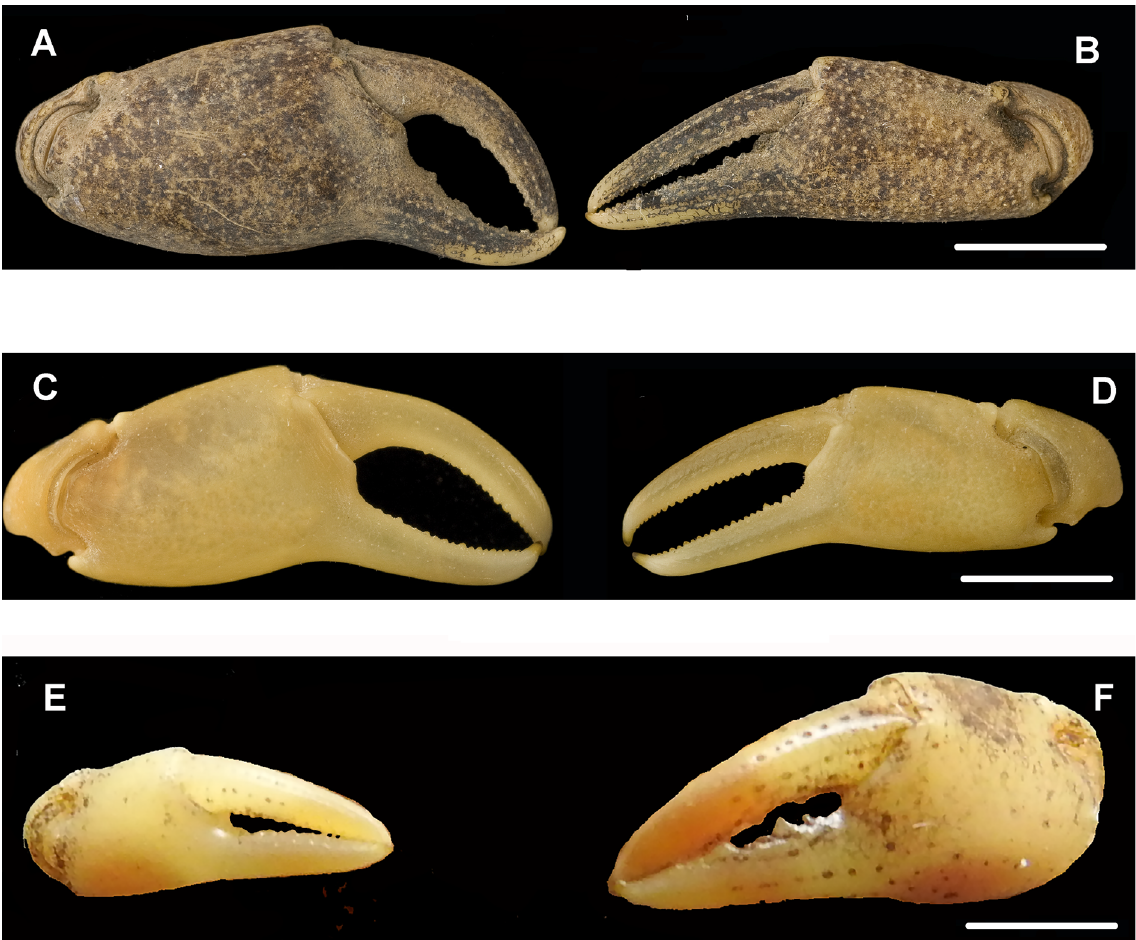
Fig. 5. Frontal view of left and right chelipeds. A–B . Potamonautes entebbe sp. nov., holotype, adult ♂, CW 35 mm, from Entebbe in southern Uganda (NHMUK 1955.11.8.26). – C–D . Potamonautes busungwe sp. nov., holotype, adult ♂, CW 21.5 mm, from Entebbe in southern Uganda (NHMUK 2017.37). – E–F . Potamonautes kantsyore sp. nov., holotype, adult ♂, CW 16.8 mm, from Kantsyore Island in the Kagera River in southern Uganda (NHMUK 2017.29). Scale bar: A–B = 2.3 mm; C–D = 3.1 mm; E–F = 3.3 mm. Photographs A–D by Phillip Crabb,